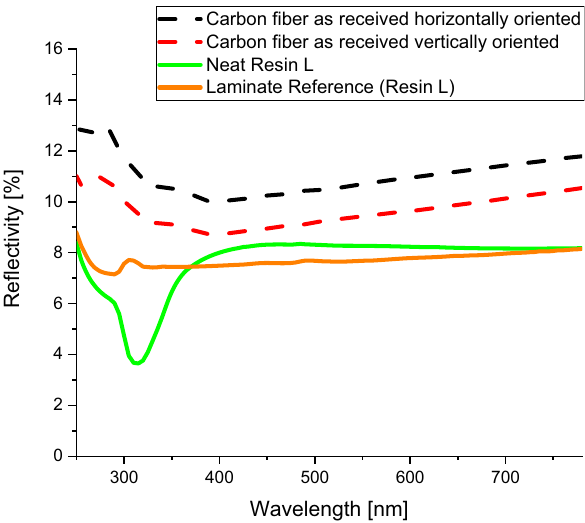
Figure 11: SiO 2 - modi fi ed carbon fi bers using 60 V and 1